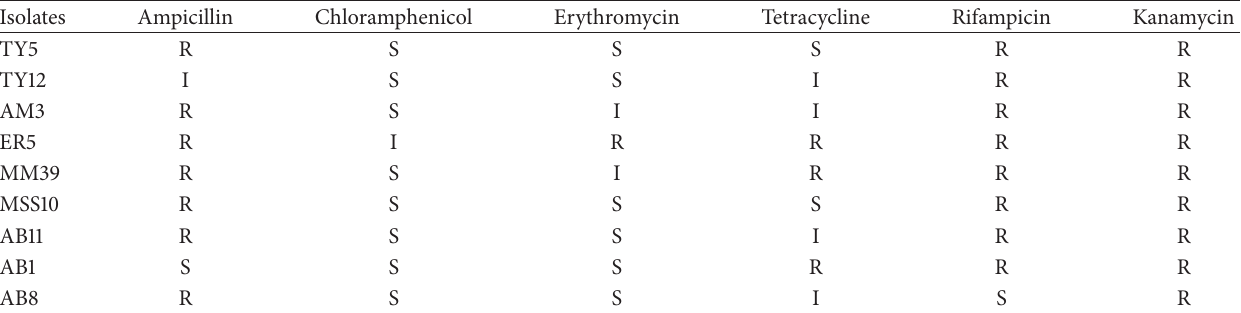
Table 6: Antibiotic susceptibility test of LAB